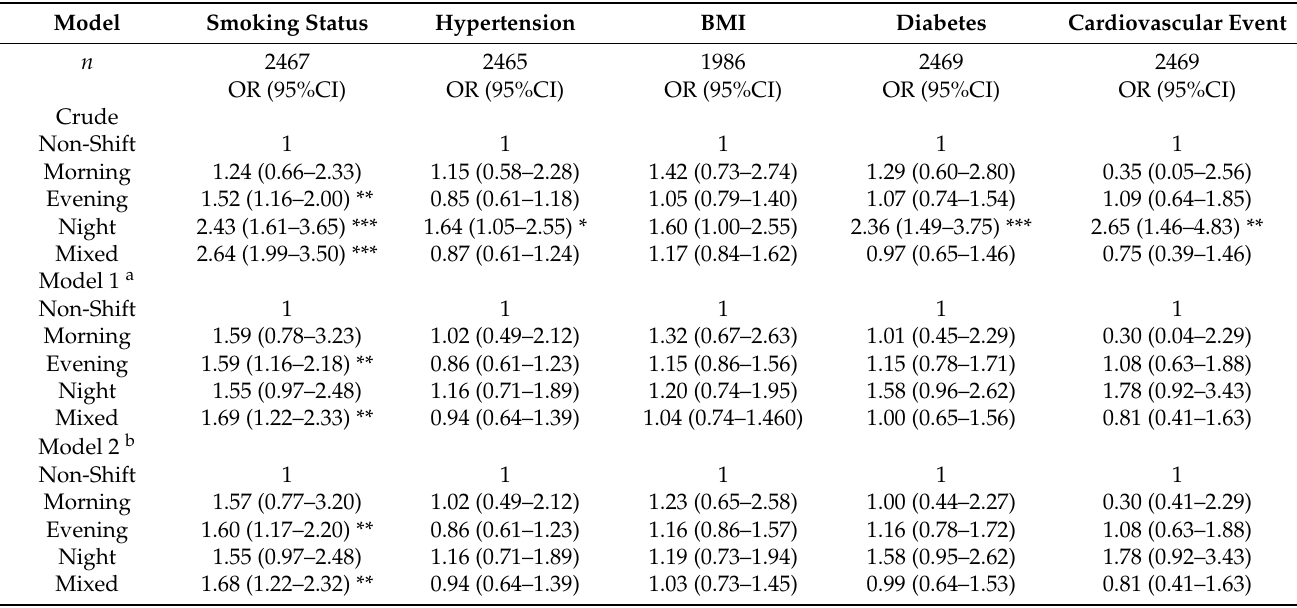
Table 2. Binary logistic regression of associations between shift schedule type and CMD risk factors and disease outcomes.